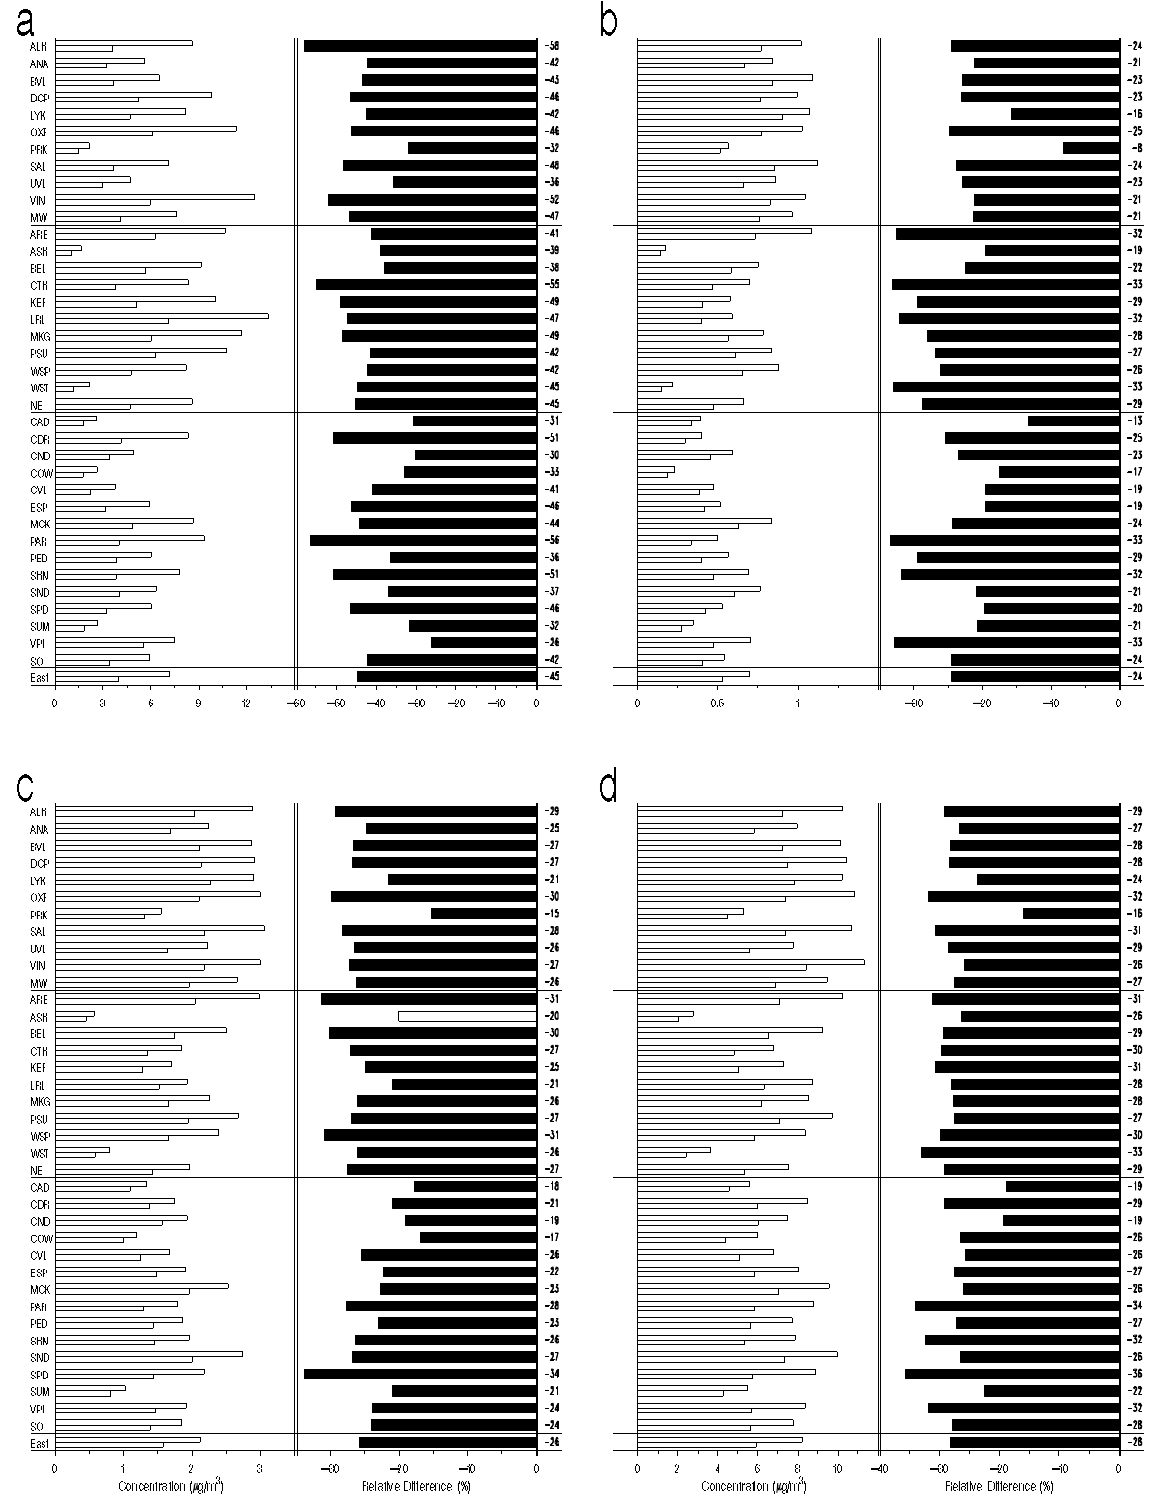
Figure 5. Site- and region-specific concentration (µgm − 3 , left – upper bar, P1; and lower bar, P4) and P1-to-P4 relative changes (%, right and bottom) for (a) S: monitored oxidized sulfur (µgSm − 3 ); (b) OxN: monitored oxidized nitrogen (µgNm − 3 ); (c) N: monitored oxidized plus reduced nitrogen (µgNm − 3 ); and (d) CASTNET PM: sum of aerosol SO 4 , NO 3 , and NH 4 (µgm − 3 ). Significance level of period-to-period relative changes indicated by bar fill: black, p ≤ 0.05; and open, p > 0.05 (NS). Sites are identified by region in the same order as shown